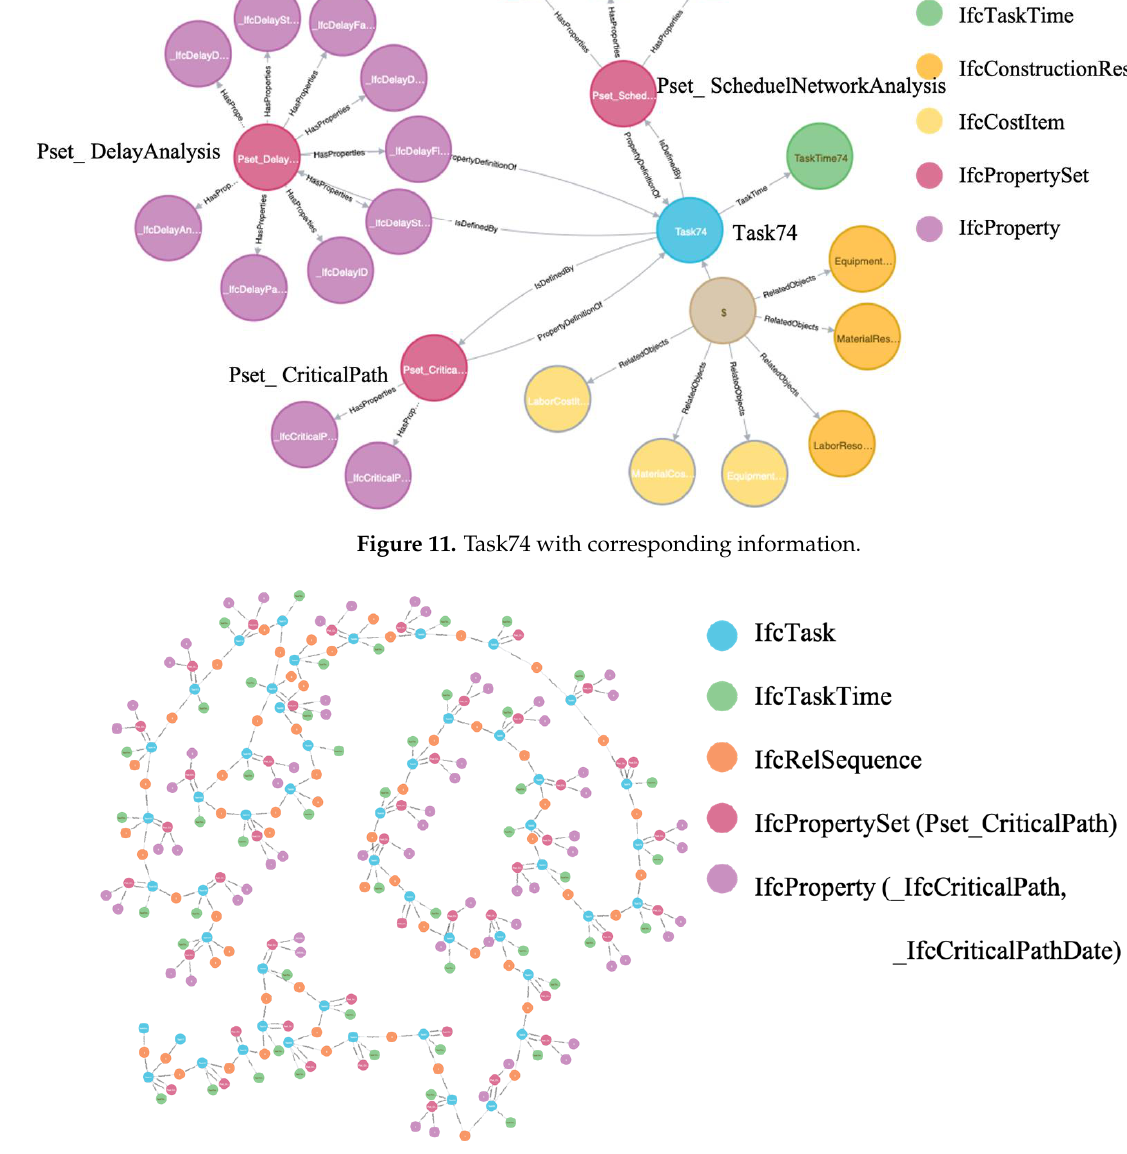
Figure 12. The critical path identified from the graph database-based information model.